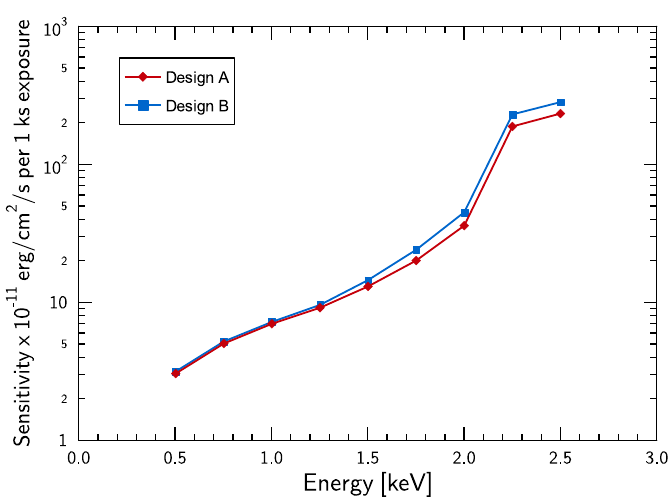
Fig. 5. Dependence of the effective area S e on photon energy.